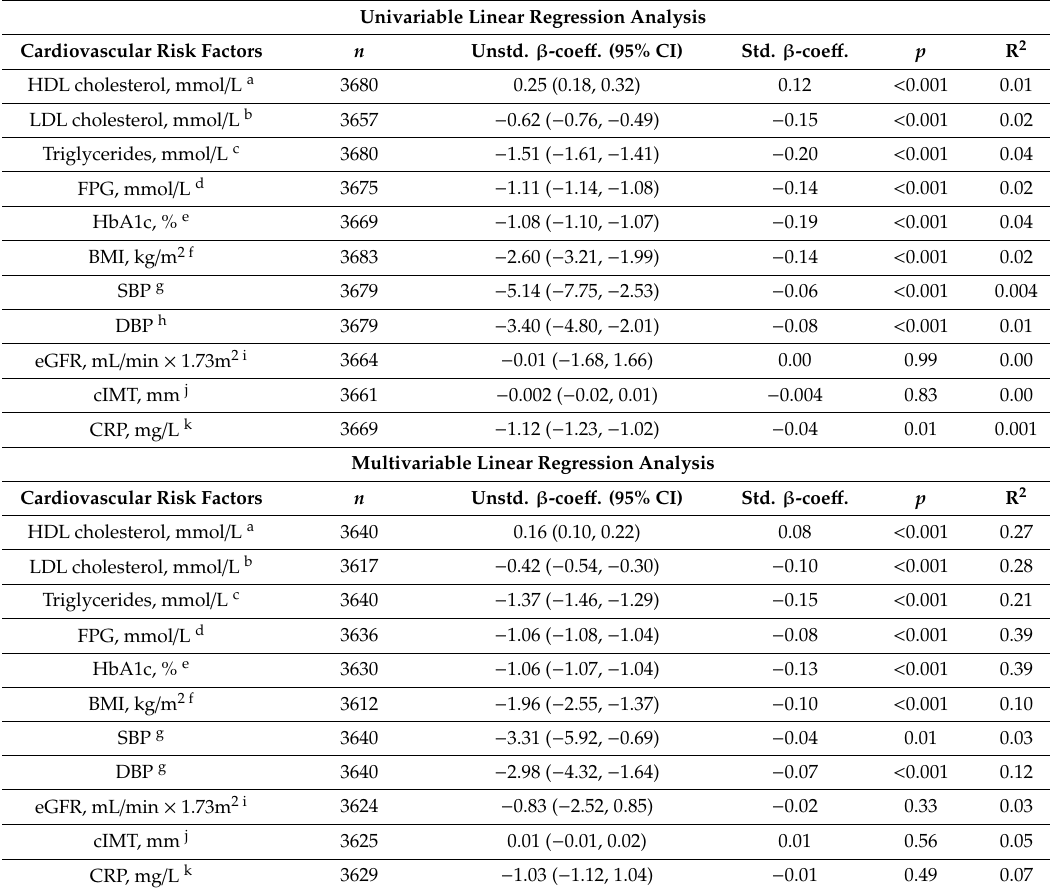
Table 3. Associations between plasma ruminant trans fatty acid levels and cardiovascular risk factors. Univariable Linear Regression